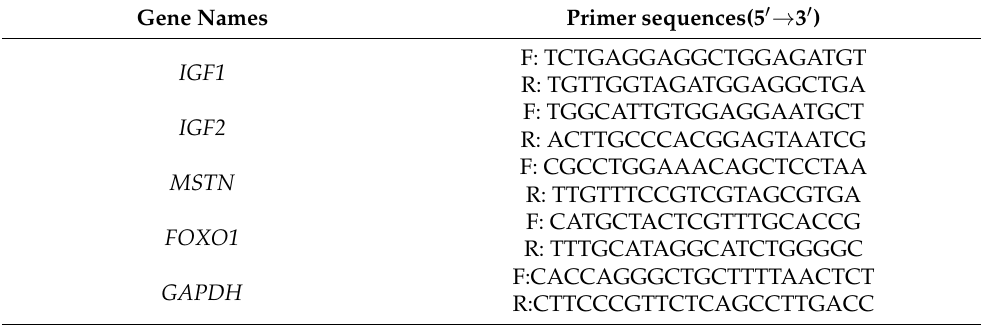
Table 2. Primers for